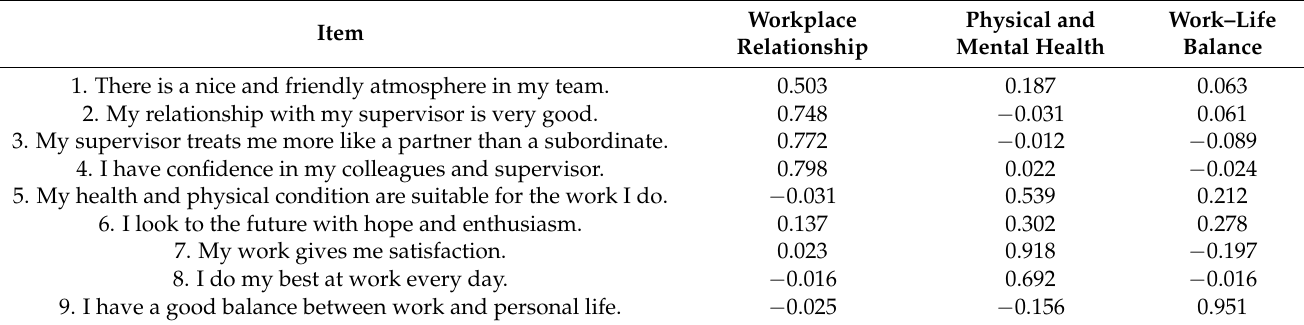
Table 2. Rotated component matrix—“employee